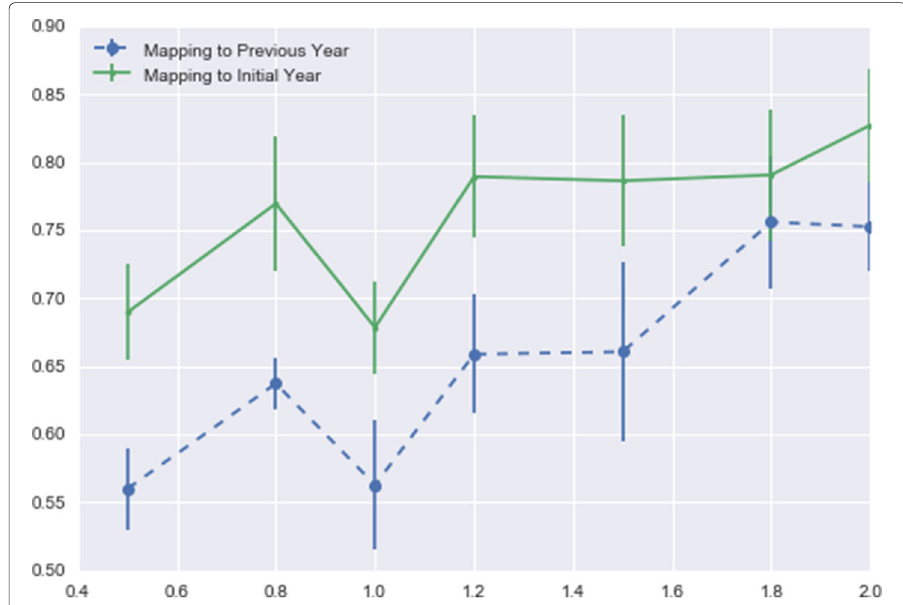
Fig. 3 Occurring rate statistics at different resolutions. The mean value and standard deviation of the occurring rate over all the nodes, using the 10-year time window rolling from year to year, including 25 time windows with initial years from 1980 to 2004. The x-axis indicates various resolution values, and the y-axis is the scale of mean values. Results from two mapping methods are shown in this